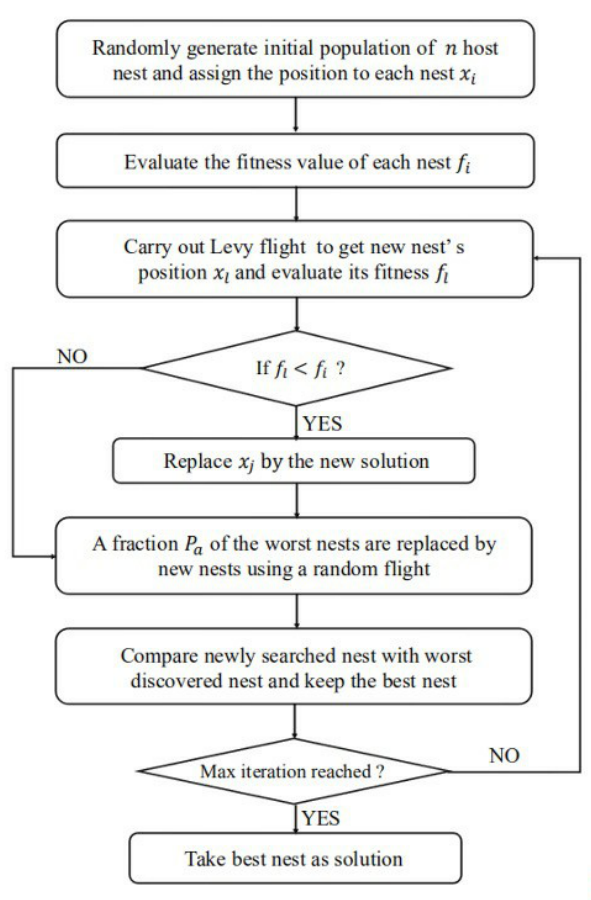
Figure 2. The flowchart of cuckoo search